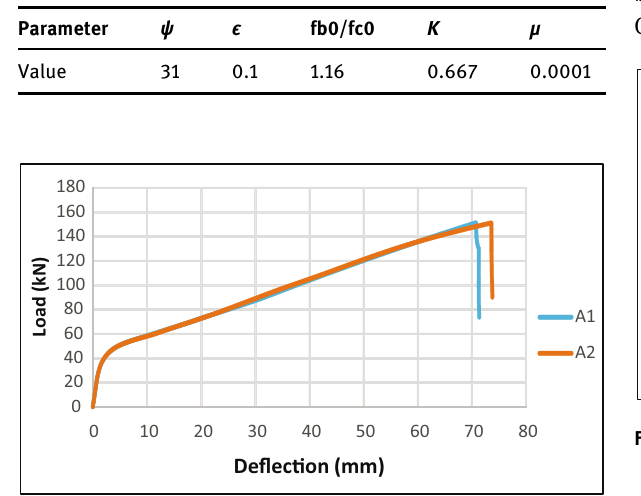
Figure 6: Load – de fl ection curve for specimens beams A1 and A2.